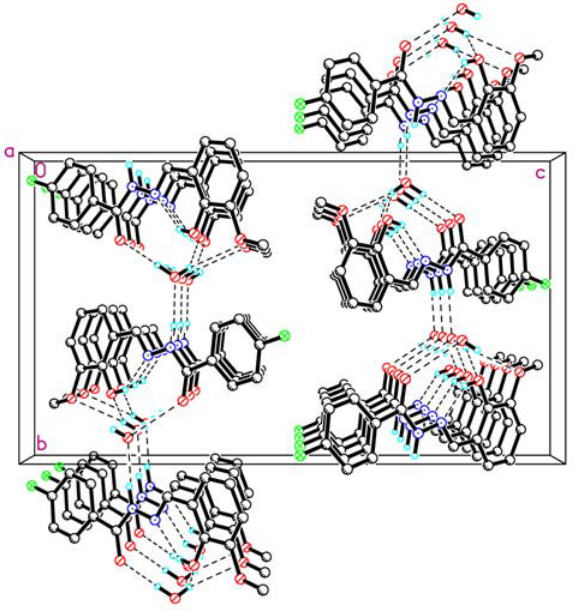
Figure 2. The crystal packing of H a axis. Hydrogen bonds are shown as dashed lines.